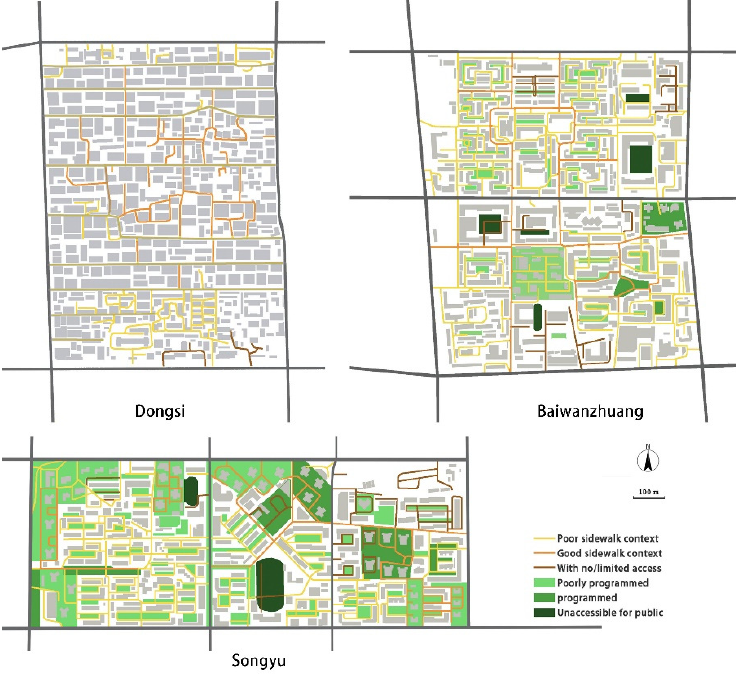
Figure 4. Sidewalks and green structures in the neighborhoods. Gated living areas exacerbate the divisions. Dongsi is an open-block